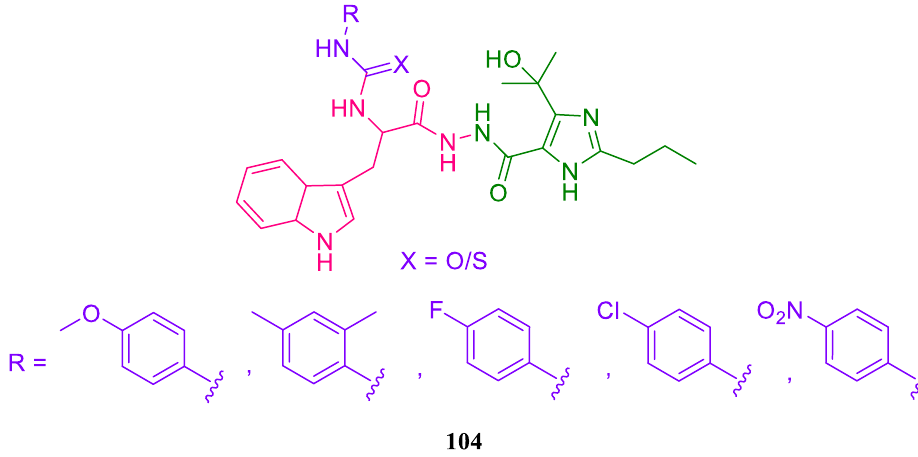
Figure 84. Tryptophan conjugated to imidazolo-derived thioureas/ureas. Rakesh K P et al. synthesised a new series of quinazolinone-Schiff bases ( 105 ) conju- gated with various amino acids and evaluated their in vitro anticancer potential against different human cancer cell lines, followed by DNA-binding and molecular docking stud- ies (Figure 85). The anticancer activity revealed that conjugates of Phe and Trp showed the highest antitumor activity. Phe analogues showed IC 50 values of 65.99 ± 1.51, 31.11 ± 1.19, 30.11 ± 1.08 and 29.11 ± 1.09 µg/mL, while Trp analogues exhibited 72.12 ± 0.06 30.34 ± 1.08 29.34 ± 0.98 29.66 ± 0.67 µg/mL against PBMC, MCF7, MDA-MB-435 and A549 cell lines. The DNA binding studies revealed that Phe and Trp conjugates reported the highest activity with IC 50 values of 48.33 ± 0.18 and 48.36 ± 1.39 µg/mL. From the SAR studies, the conjugates with amino acids, Phe and Trp and the presence of EDGs, such as -OH and - OCH 3 , presented enhanced anticancer activity with good binding capacity with DNA, whereas the molecules having EWGs, such as -F, -Cl and -NO 2 , reported much less anti- cancer activity. The molecular docking studies revealed that conjugates of Phe and Trp showed the highest docking scores of − 7.948 and − 7.400, respectively [173]. Figure 85. Amino acids-quinazolinone-Schiff bases.